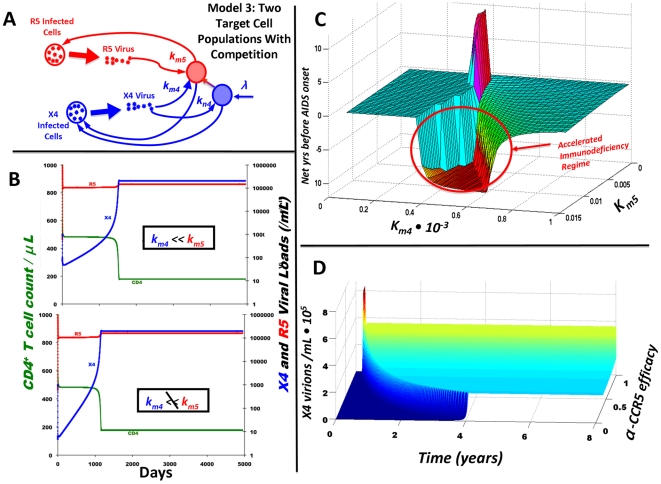
A model with two target-cell populations and viral competition in one of these populations matches in vivo data and predicts that R5 inhibitors accelerate AIDS onset.(A) A schematic of Model 3, a competitive model with two target-cell populations. (B) The model exhibits a coreceptor switch at approximately 1000–1400 days post-infection in two types of parameter regimes: the “non-competitive regime” in (B, upper panel) and the “competitive regime” (B, lower panel). For the “non-competitive regime,” parameter values are: λ = 33 cells/(µl•day), c = 23/day, p = 2100/day, f = 0.8, δ = 0.5/day, kN4 = 0.00108 µl/(virions•day), kM4 = 4•10−5 µl/(virions•day), and kM5 = 0.0068 µl/(virions•day), while in the “competitive regime” we change kM4 to 5•10−4 µl/(virions•day) and kN4 to 0.001 µl/(virions•day) (decreased in order to keep X4 in check). (C) The net effect of a CCR5 inhibitor with 80% efficacy on the time to AIDS across different kM4 and kM5 levels (i.e. different competitive and non-competitive regimes). AIDS onset is defined as the time at which CD4+ T cell counts fall below 200 cells/µl: negative values represent accelerated times to AIDS-onset relative to no treatment. R5 inhibitors clearly accelerate AIDS-onset for a large fraction of parameter space. (D) Time-dependency of X4 emergence as a function of CCR5 inhibitor efficacy (α-CCR5 efficacy) in the “competitive regime.” Increased CCR5 inhibitor efficacy accelerates X4 emergence and increases X4's viral set point.